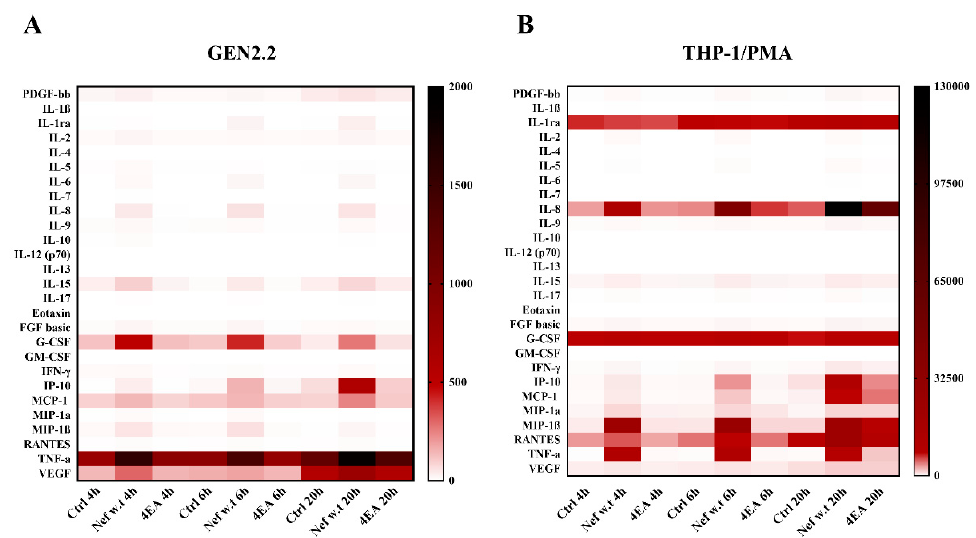
Figure 7. Profile of cytokines/chemokines released by GEN2.2 cells and THP-1/PMA in response to Nef treatment. GEN2.2 cells were seeded at the density of 1 × 10 6 /mL in a 24-well plate, whereas THP-1/PMA cells were seeded at 100,000 cells/cm 2 in a 6-well plate. Both cell types were or were not treated with 300 ng/mL of myrNef SF2 w.t or myrNef SF2 4EA in a final volume of 2 mL. Supernatants were collected after 20 h, centrifuged at 290 × g for 3 min to remove cells and analysed with Bio-Plex Pro Human Cytokine 27-Plex Immunoassay. ( A ) Heat map of cytokines/chemokines released by GEN2.2 cells. The color scale range is 0–2000 pg/mL. ( B ) Heat map of cytokines/chemokines released by THP-1/PMA cells. The color scale range is 0–130,000 pg/mL. Each row represents a cytokine/chemokine, whereas each column represents a sample. The values mapped are the mean of two independent experiments evaluated in triplicate.